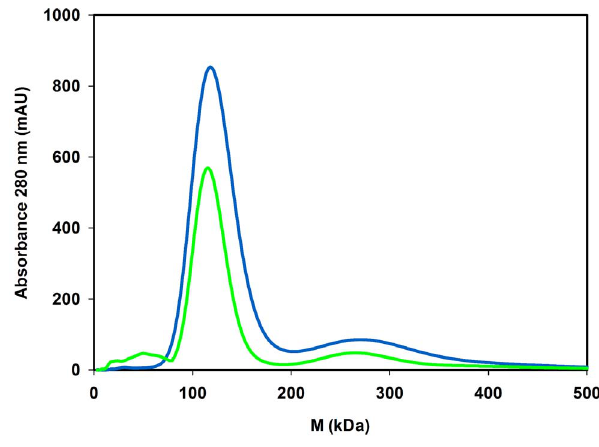
Figure 3. Size exclusion chromatography of Ta AlDH. Samples contained soluble Ta AlDH (blue) and refolded Ta AlDH (green).